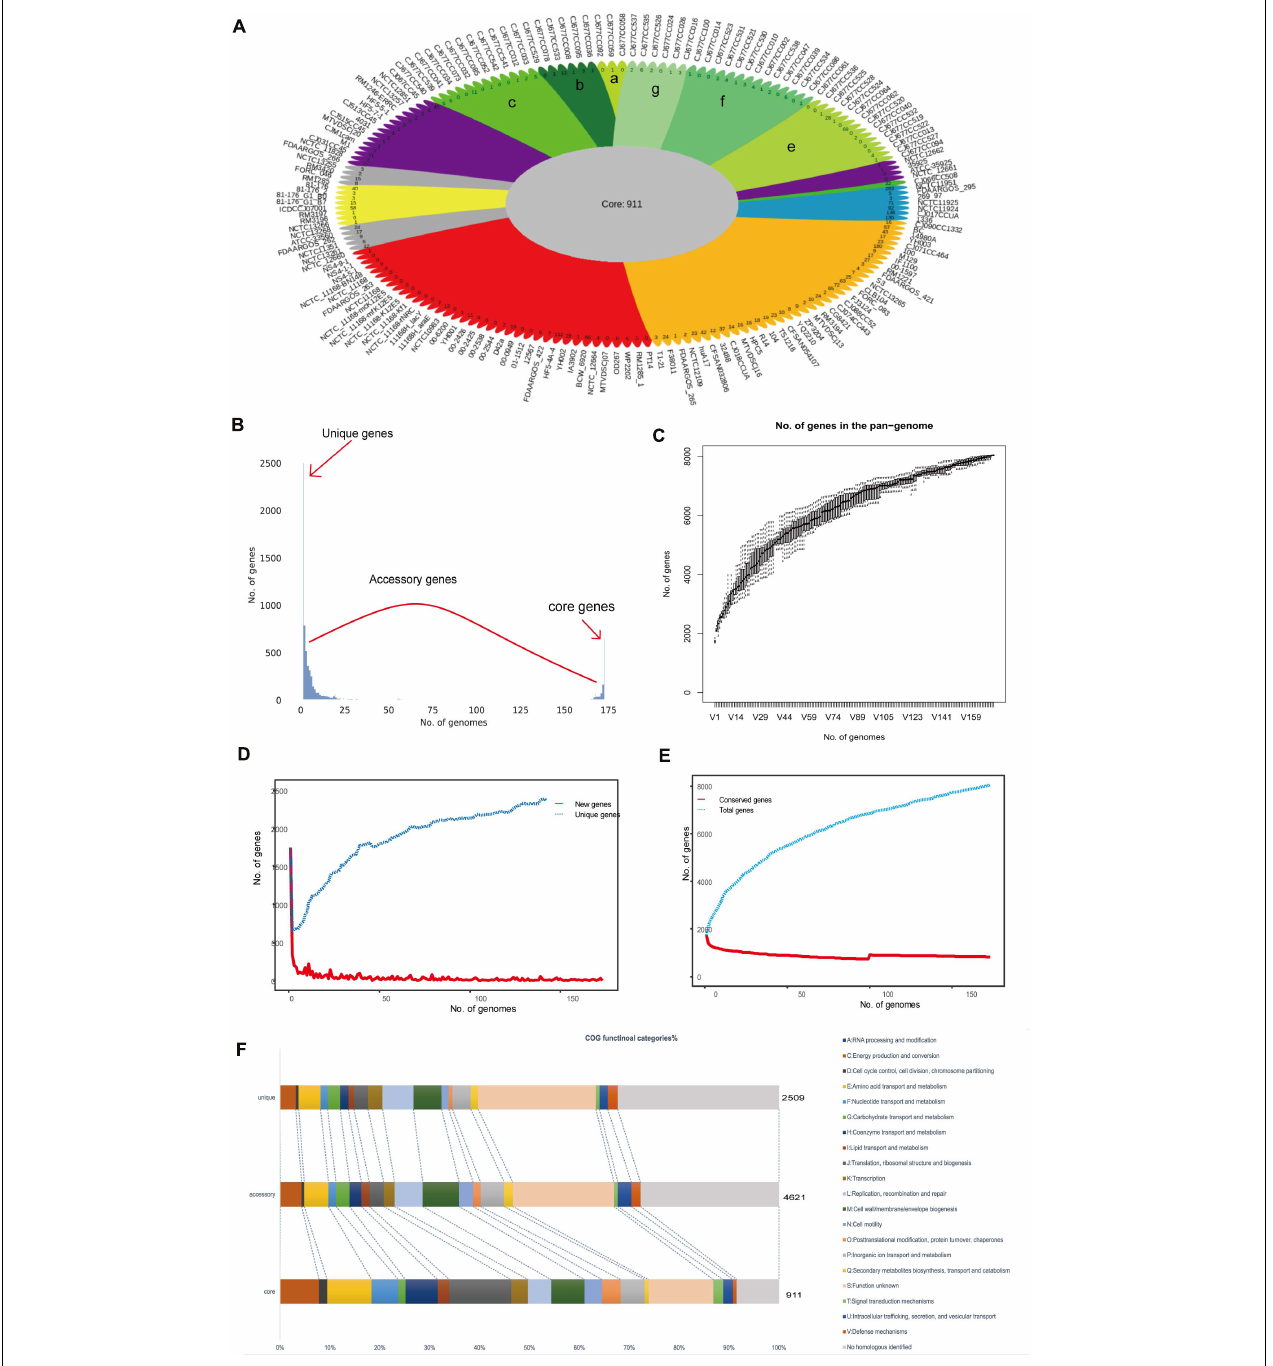
FIGURE 2 | Pangenome shape of Campylobacter jejuni . (A) Pangenome flower plot showing the core genome and the different unique genes for each strain. Different colors represent the subgroups in the pangenome tree (the colors correspond to the different clades in the core genome tree). The number of subgroups is labeled with lowercase letters , except “ d ,” which includes the rest of the region between two purples . Different shades of green are used to distinguish the different subgroups, which correspond to clade V of the core genome tree. (B) Gene accumulation curves for the pangenome. Cumulative sizes were calculated by selecting strains without replacement in random order 1,000 times. (C) Histogram of the prevalence of the different gene families in the pangenome. A total of 8,041 non-redundant gene families identified in 173 genomes are based on their frequency distribution. Three gene categories are clearly distinguished, highlighting the unique genes (genes that only exist in one strain), core genes (gene families are present in all the analyzed strains), and accessory genes (gene families that exhibit variable frequencies). (D) Heaps’ law graph representation of new genes ( red line ) and unique genes in 173 genomes. (E) Heaps’ law graph representation of the conserved genes ( red line ) and the total genes in 173 genomes. (F) Distributions of the Clusters of Orthologous Genes (COG) categories in the core, accessory, and unique genes without homologs were marked in gray .